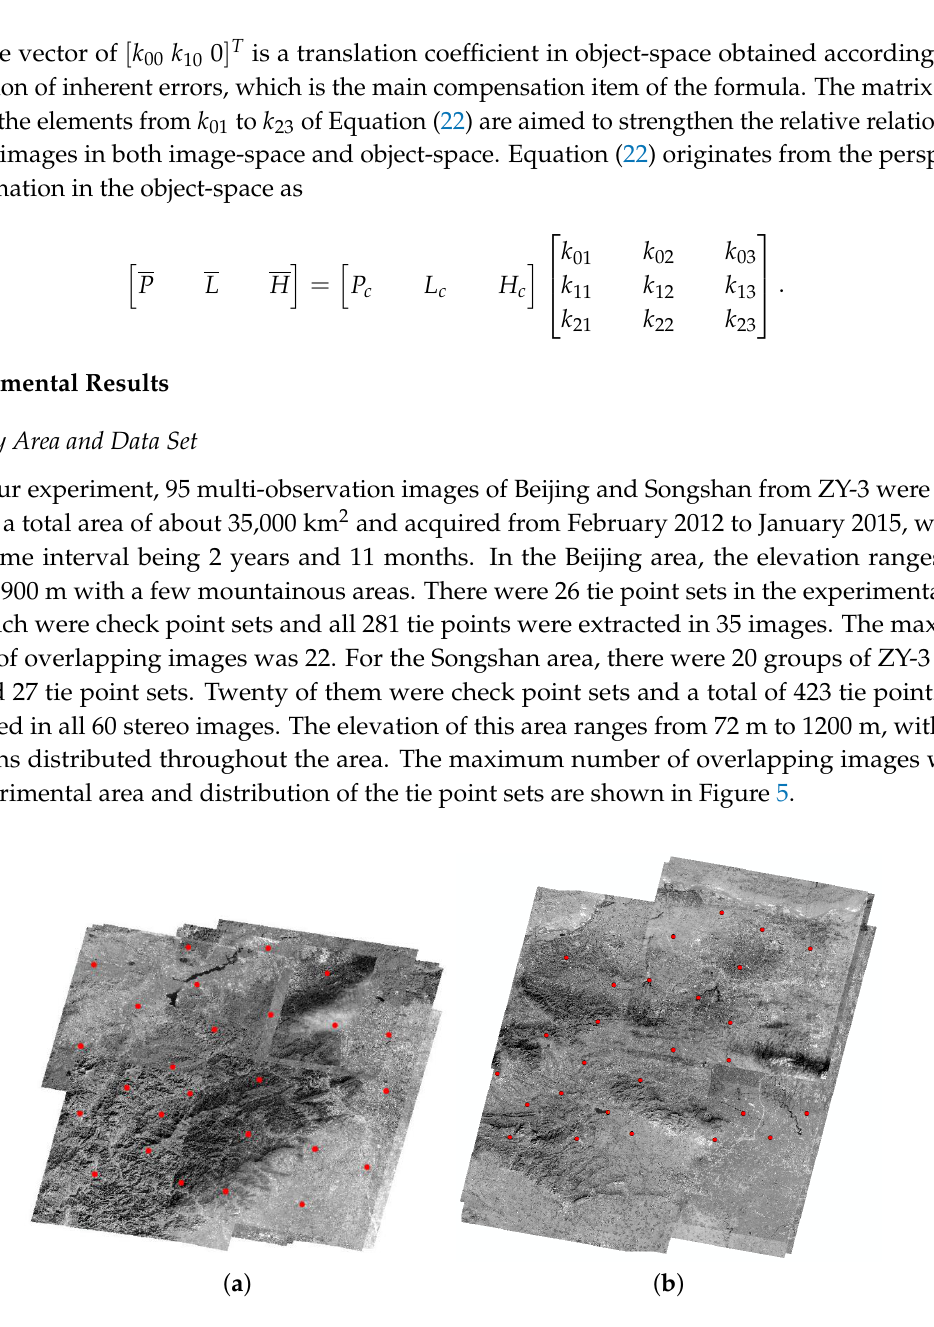
Figure 5. Experimental data distribution of ( a ) Beijing and ( b ) Songshan